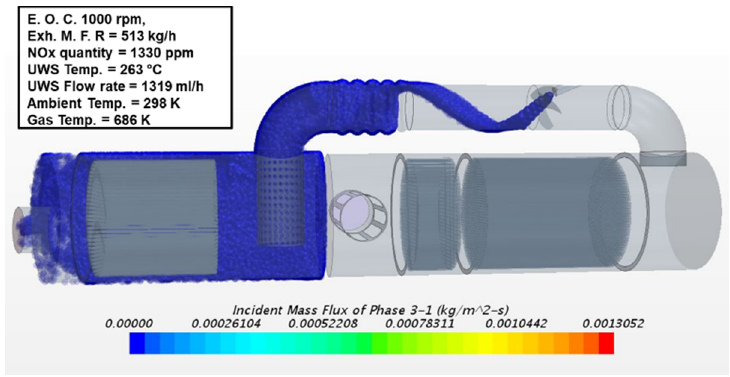
Figure 4. The quantity of incident mass flux in the SCR system.